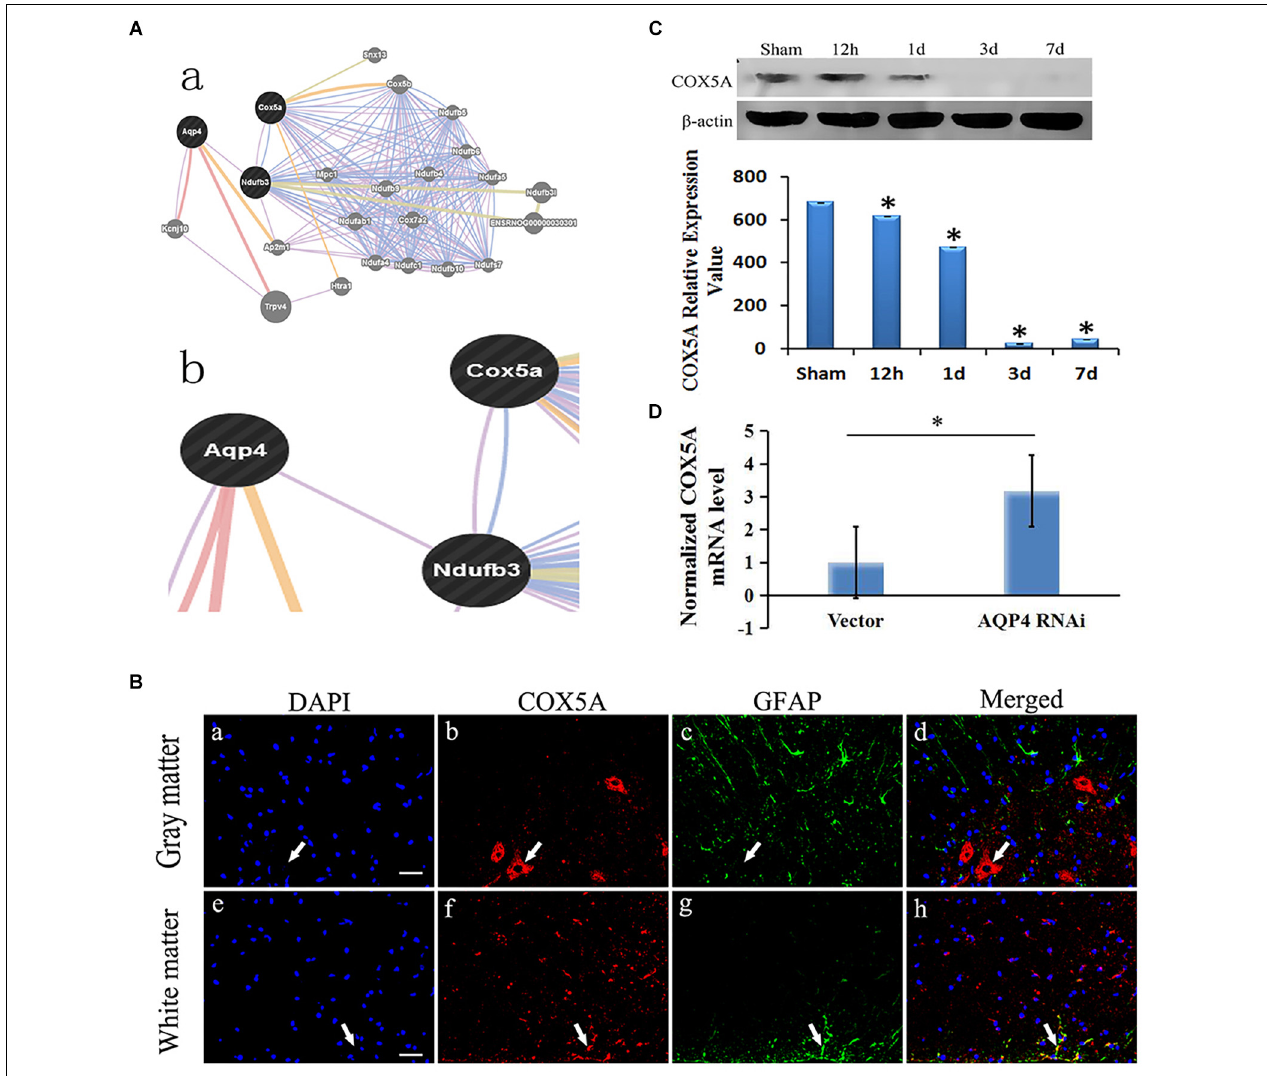
FIGURE 4 | Correlation of AQP4 and COX5A in cytotoxic edema with SCC. (A) (A-a) , Detailed analysis shows the results of bioinformatical analysis. (A-b) : part of the bioinformatical analysis showed that AQP4 was co-expressed and co-localized with NADH dehydrogenase (ubiquinone) 1 beta subcomplex 3 (Ndufb3), COX5A and Ndufb3. (B) Immunofluorescence analysis demonstrated that COX5A (red) emerged in the anterior horn of spinal cord at 3 days after SCC. (B-a–d) : co-expression of GFAP and COX5A in the gray matter of the spinal cord. (B-e–h) : co-localization of GFAP and COX5A in white matter of spinal cord. (B-a) : the nuclei were labeled by DAPI (blue). (B-b) : COX5A immunoreaction (red). (B-c) , GFAP immunoreaction (green). (B-d) : merged (yellow) shows co-expression of DAPI and COX5A. (B-e) : the nuclei are in white matter by DAPI (blue). (B-f) , COX5A immune reactions (red). (B-g) , GFAP-positive neurons, green. (B-h) , Co-localization of COX5A and GFAP (yellow). Bar = 40 µ m. (C) Western blotting shows the immunostaining of COX5A and beta-actin at sham, 12 h, 1 day, 3 days and 7 days. The density of bands was measured by ImageJ. Data were normalized to beta-actin. The expression of COX5A protein was significantly decreased compared to the sham group at 12 h, 1 day, 3 days, and 7 days after SCC. ∗ P < 0.05 when compared to sham group ( n = 8). (D) Following AQP4 lentivirus transduction in vivo , the expression of COX5A was detected by qRT-PCR. The level of COX5A was significantly increased in the AQP4-RNAi-LV group compared to the vector group. ∗ P < 0.05 when compared to vector group ( n =